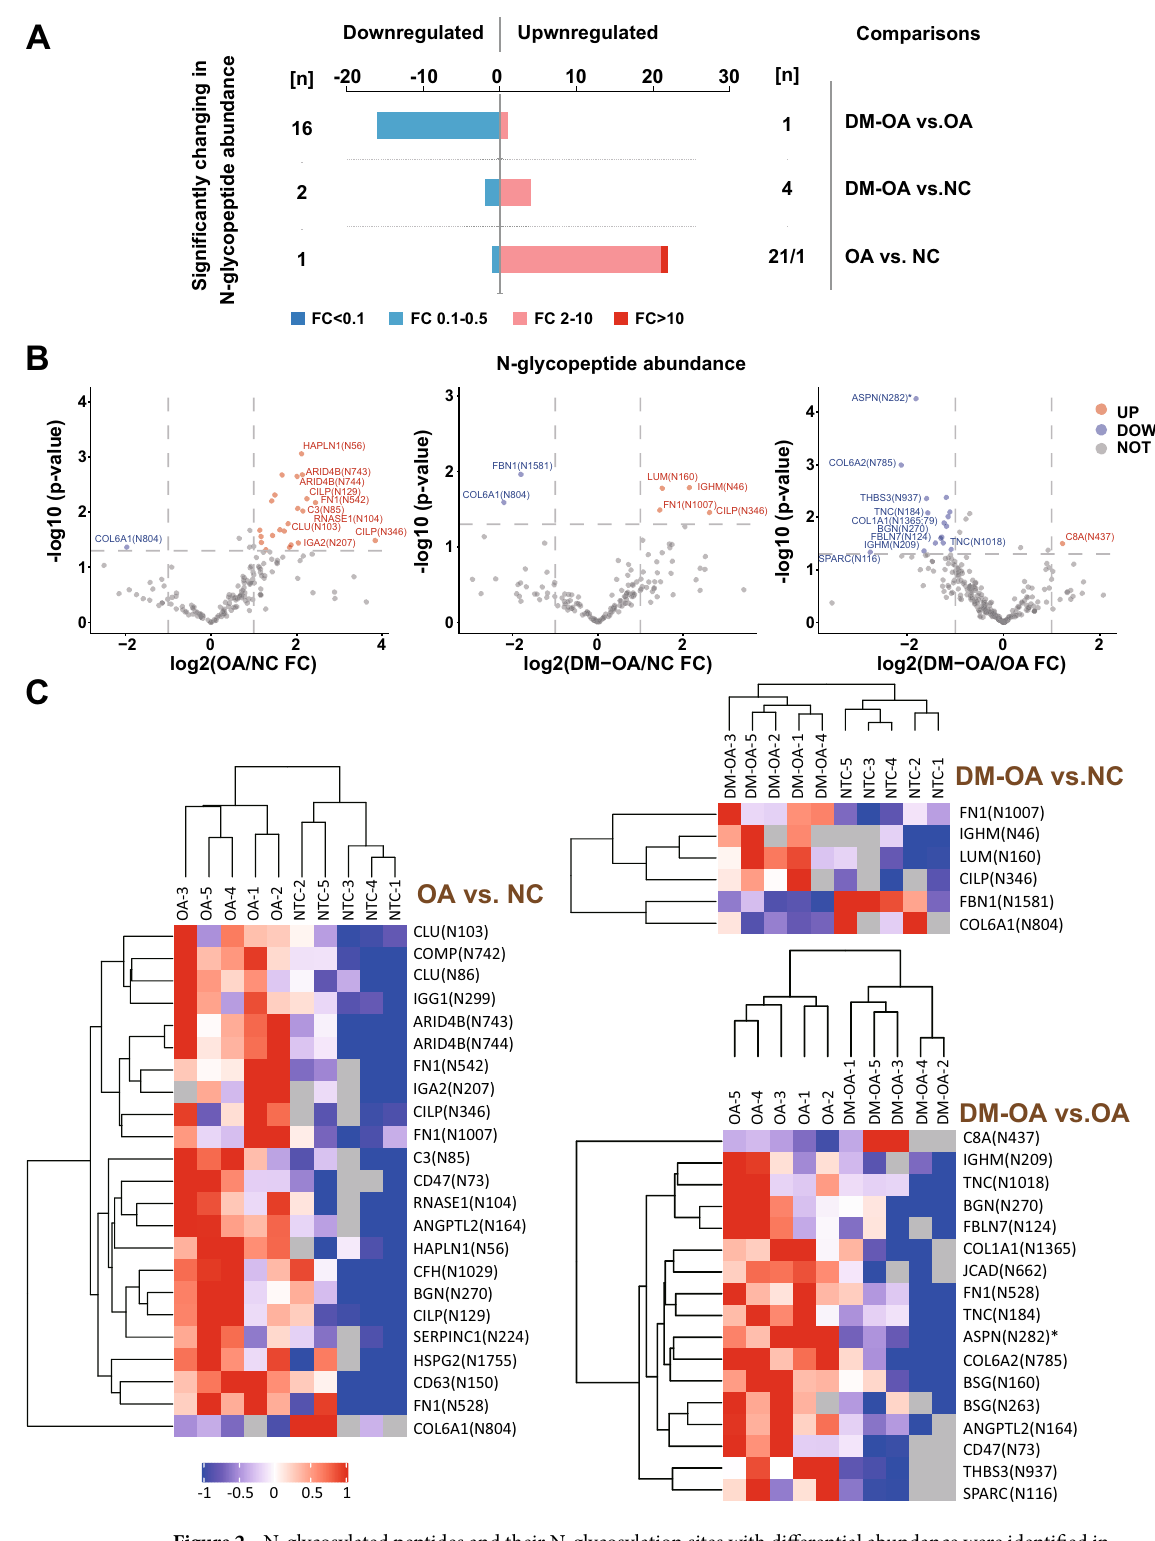
Figure 2. N-glycosylated peptides and their N-glycosylation sites with differential abundance were identified in pairwise comparisons of OA, DM-OA, and normal control. ( A ) The number of N-glycosylated peptides identified in pairwise comparisons of OA, DM-OA, and normal control groups with the criteria of the fold change (FC) > 2 (red) or < 0.5 (blue) and P < 0.05. Dark red and dark blue indicated criteria of FC > 10 or < 0.1. ( B ) Volcano diagrams for each pairwise comparison drawn by logarithmically transformed change folds versus P -value. ( C ) Hierarchical clustering drawn by Cluster 3.0 (http:// bonsai. hgc. jp/ ~mdeho on/ softw are/ clust er/ softw are. htm) and Java Treeview software (http:// jtree view. sourc eforge. net) based on the N-glycopeptides abundance profiles and heatmaps (Complexheatmap R Version 3.4) showing the abundances of N-glycopeptides containing N-glycosites in pairwise comparisons, while all of these groups with the criteria of the FC > 2 (red) or < 0.5 (blue) and unadjusted P < 0.05. * indicate an FDR <